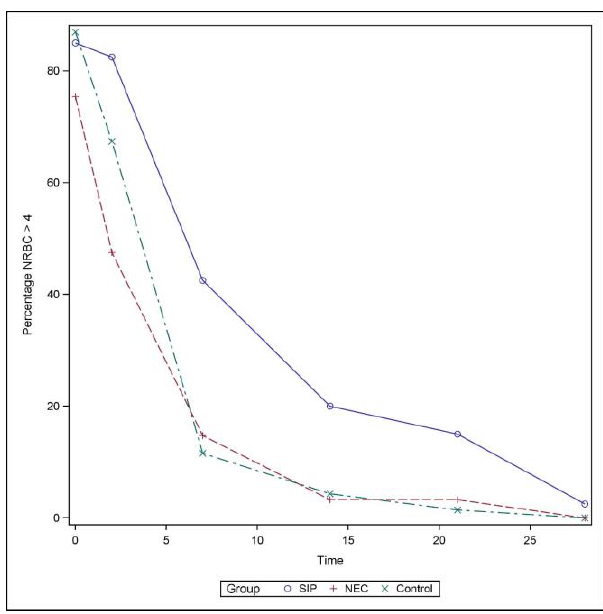
Figure 4: Percentage with NRBC >